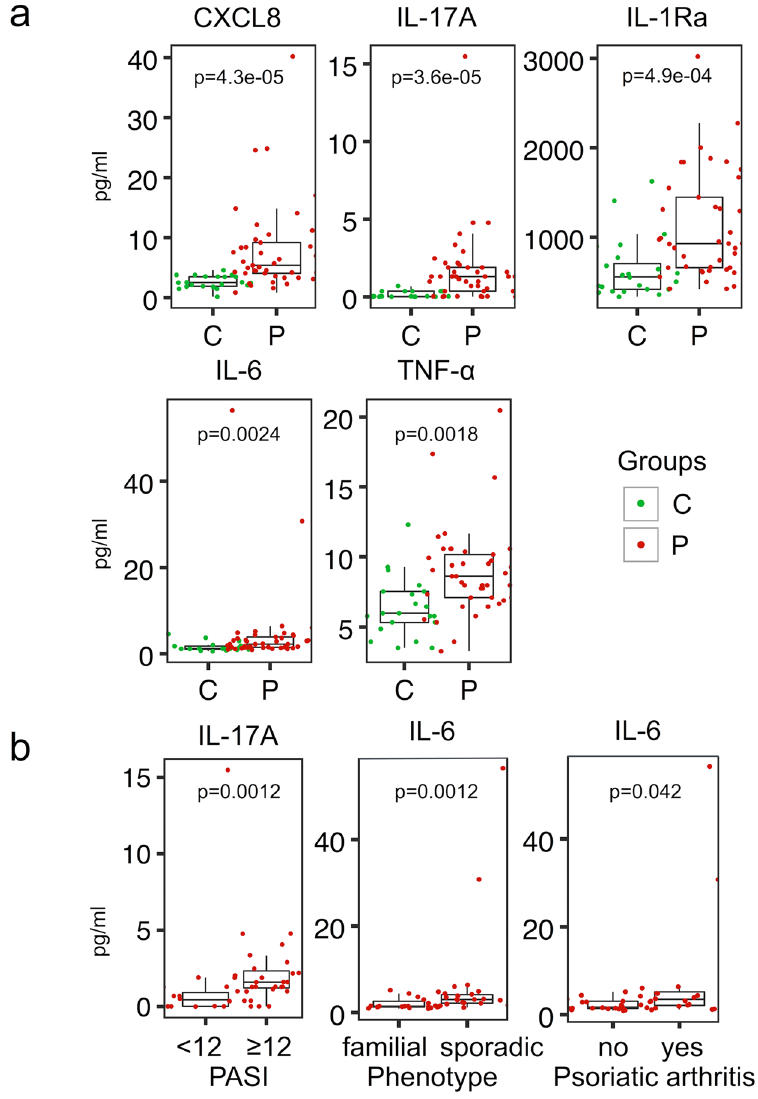
Figure 5. Comparison of circulating immune mediators in psoriasis patients and control individuals. ( a ) The Luminex method was used to determine the cytokine and chemokine concentrations in plasma samples of psoriasis patients (P) and control individuals (C). ( b ) Comparison of circulating cytokine levels in psoriasis patients with different clinical features. The box-and-whisker plots depict median (central line), interquartile range (IQR, Q1-Q3, box), Q3 + 1.5 × IQR (upper whisker) and Q1 − 1.5 × IQR (lower